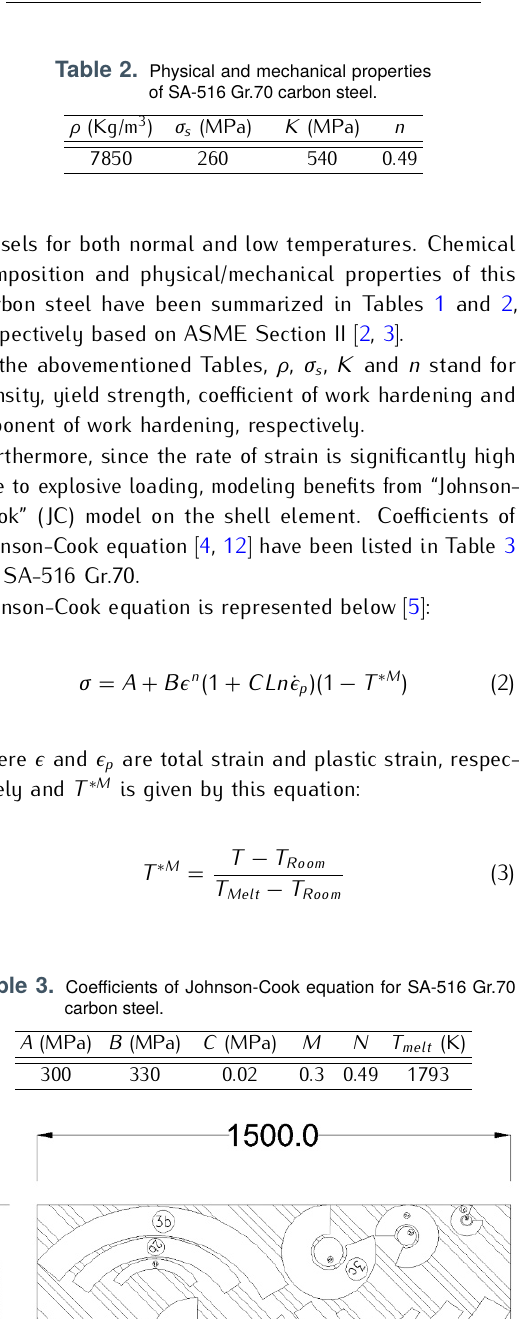
Figure 2. Expanded model of cutting